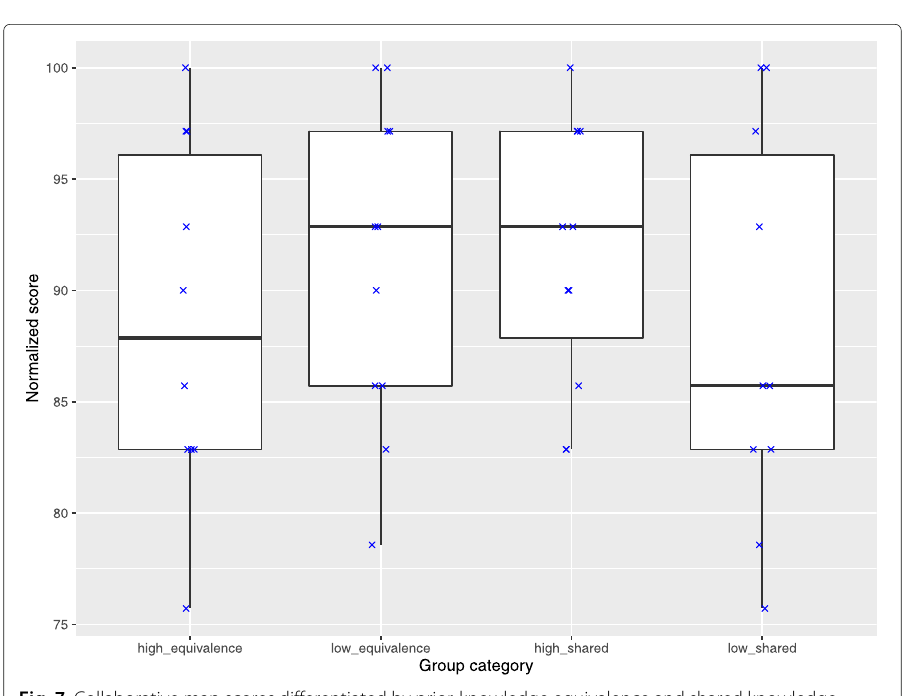
Fig. 7 Collaborative map scores differentiated by prior-knowledge equivalence and shared knowledge about the